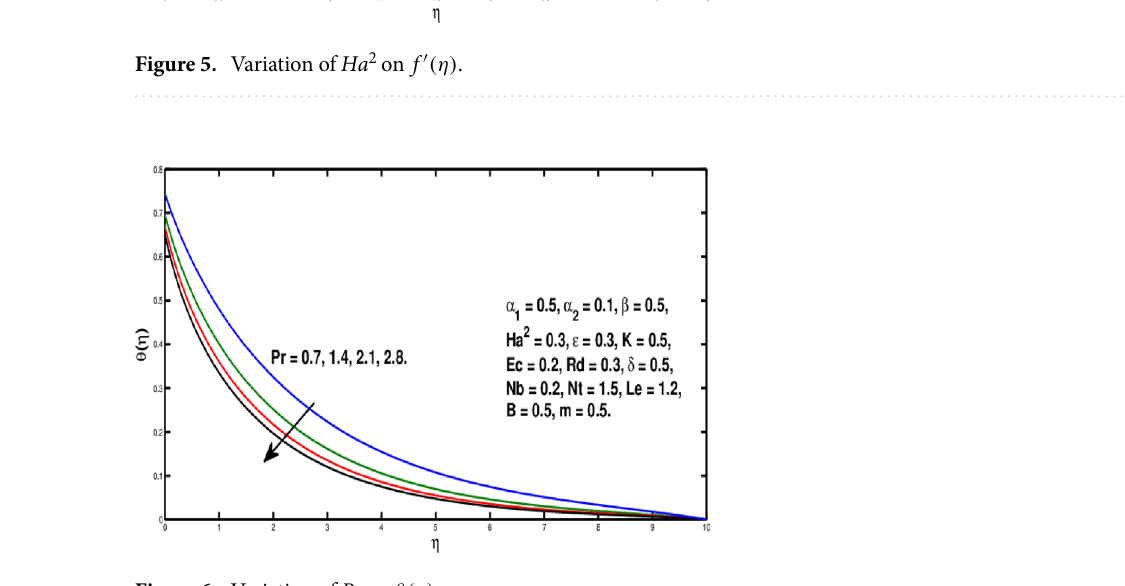
Figure 6. Variation of Pr on θ(η) .